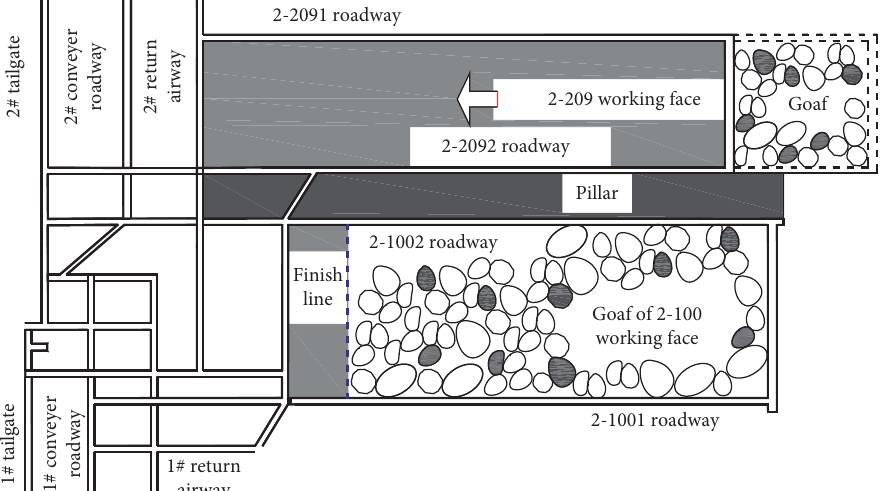
Figure 1: Spatial relationship between 2-209 working face and adjacent working